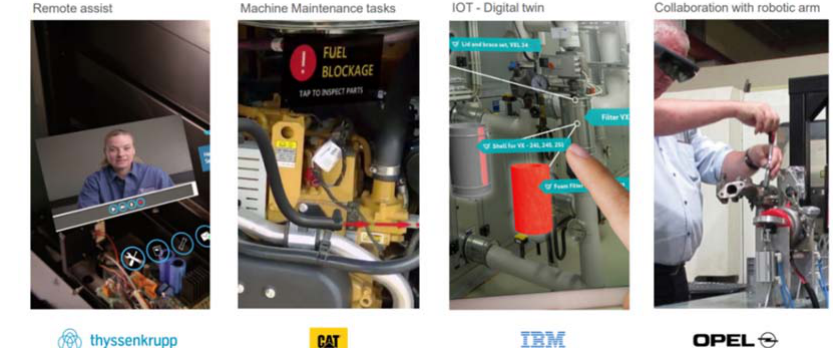
Figure 8. Integration of digital reality in assemblies / manufacturing processes [43]